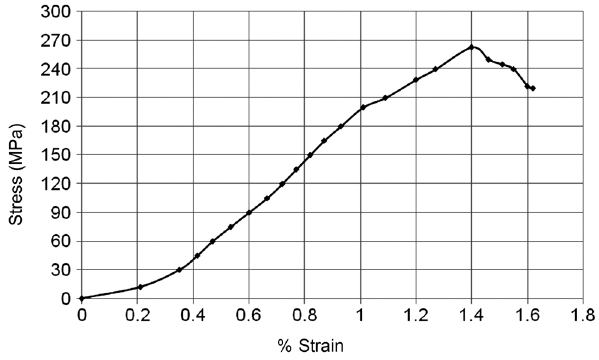
Figure 6 Stress-strain for composite (6% fly ash, 53–75 μ